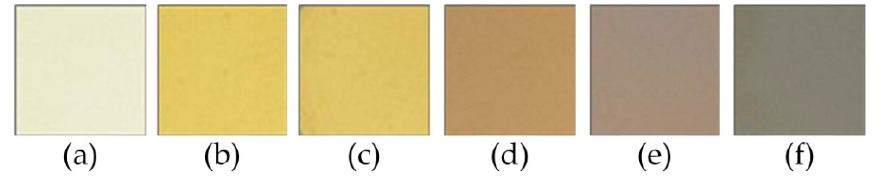
Figure 1. ZrON coatings color for O 2(x) : ( a ) 0%, ( b ) 10%, ( c ) 20%, ( d ) 30%, ( e ) 50%, ( f ) 100%.